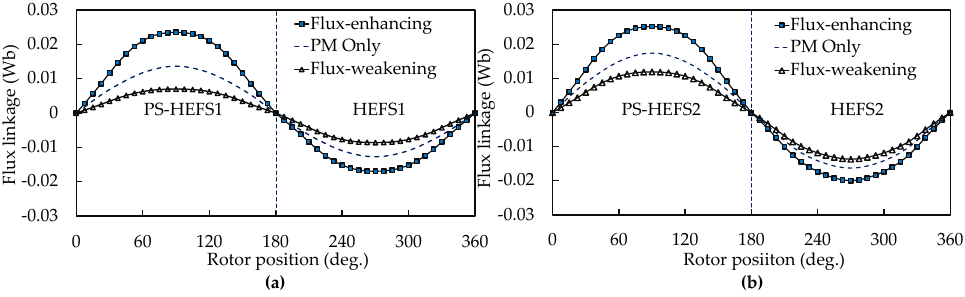
Figure 12. Flux linkages of four machines. ( a ) PS-HEFS1 and HEFS1; ( b ) PS-HEFS2 and HEFS2.